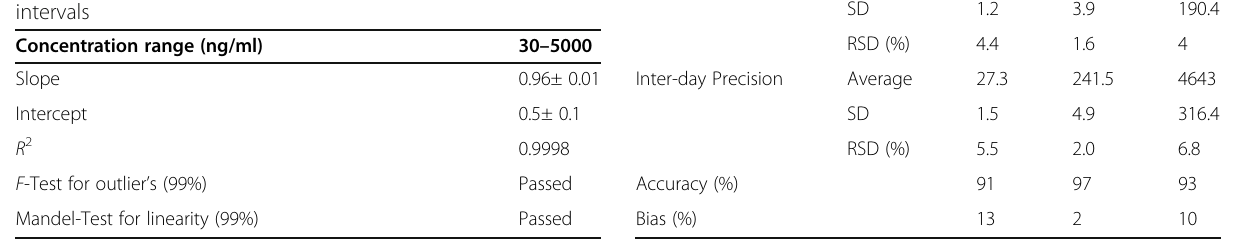
F -Test for outlier ’ s (99%) Passed Mandel-Test for linearity (99%) Passed